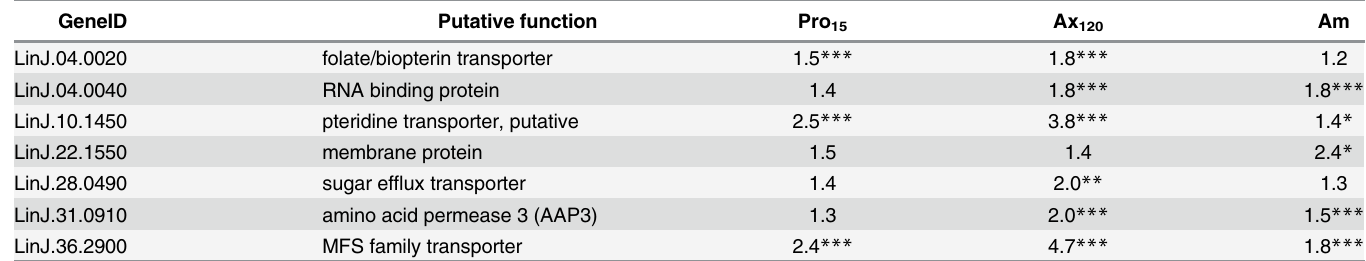
Table 1. Potential members of the ADR